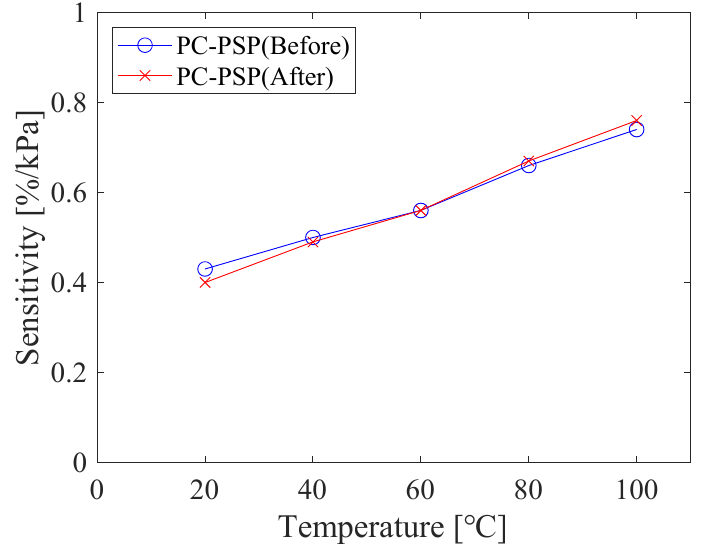
Figure 6. Pressure sensitivity of PC-PSP at different temperatures before and after the heat treatment.